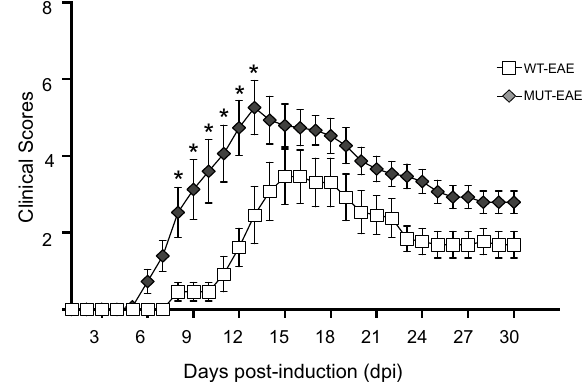
Figure 1. Clinical course of EAE. WT and MeCP2 mutant mice (MUT) were immunized with MOG and clinical signs were evaluated daily for 30 days. MUT-EAE mice showed an early EAE onset and developed more severe clinical signs in comparison to WT littermates. Data represent EAE clinical scores per group (mean ± SEM). Clinical scores per animal were calculated by adding tail and hind legs scores, and establishing a scale from 0 to 8, where 8 represents the highest EAE score per animal (i.e. 2 for the maximum tail score and 3 the maximum for each leg). Tail abnormalities were graded as: 0, no deficits, 1 partial loss of tail tone, 2 total tail paralysis. Each hind limb was graded as: 0, normal gait; 1, mild hind limb weakness; 2, dragged limp with abnormal gait; 3, complete hind limb paralysis with no residual movement. Two-factor ANOVA test with repeated measures was performed. *p < 0.05. WT-EAE n = 13; MUT-EAE n =